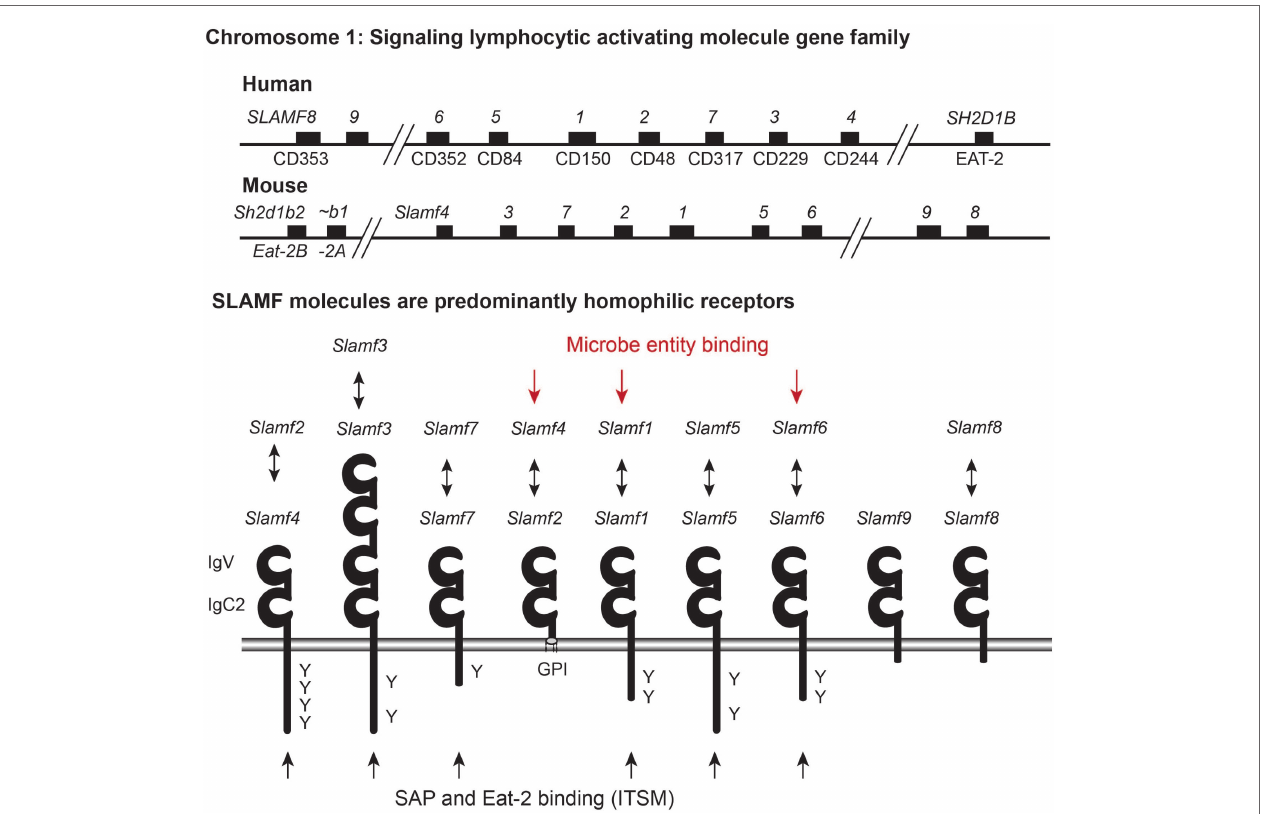
FiGURe 1 | Signaling lymphocytic activating molecule gene family (SLAMF receptors family) and proteins. Organizational overview of the SLAM family cluster on chromosome 1 in both human and mice. EAT-2 is also located proximal to this gene cluster and is duplicated in mice, encoding Eat-2a and Eat-2b. The SLAMF receptors are part of the Ig-superfamily and they have an IgV and an IgC2 domain. Seven of the SLAM receptors are homophilic ligands. SLAMF2 and SLAMF4 are co-ligands that bind each other. Three SLAM genes have been shown to possess bacterial binding capacity. Six of the SLAM receptors have docking domains for SAP (and EAT-2) represented by Y (tyrosine in ITSM). SLAMF2 is anchored to the plasma membrane by a